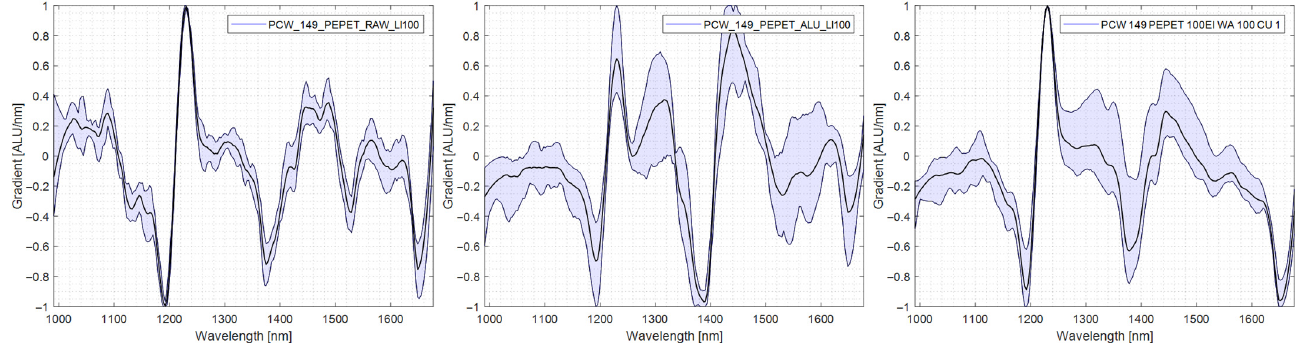
Figure 16. Comparison PE/PET spectra, left: no reflector, middle: aluminium reflector, right: copper reflector.